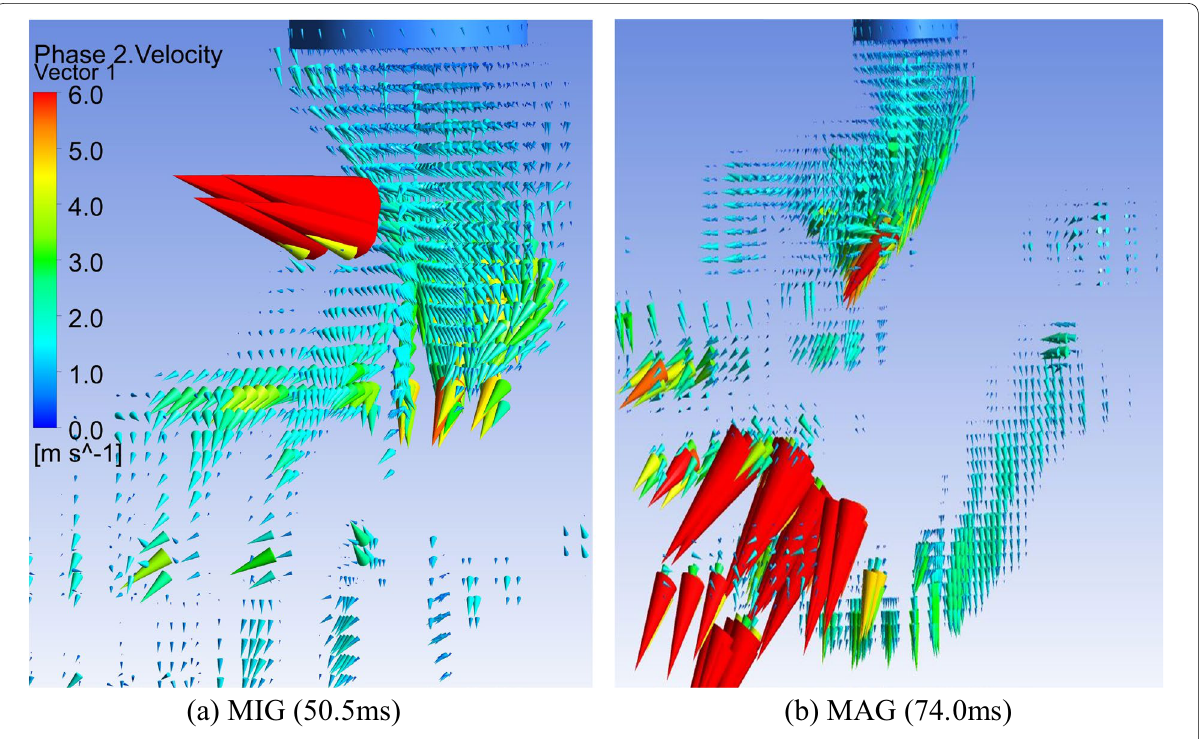
Figure 4 The velocity vector of 500 A MIG and MAG